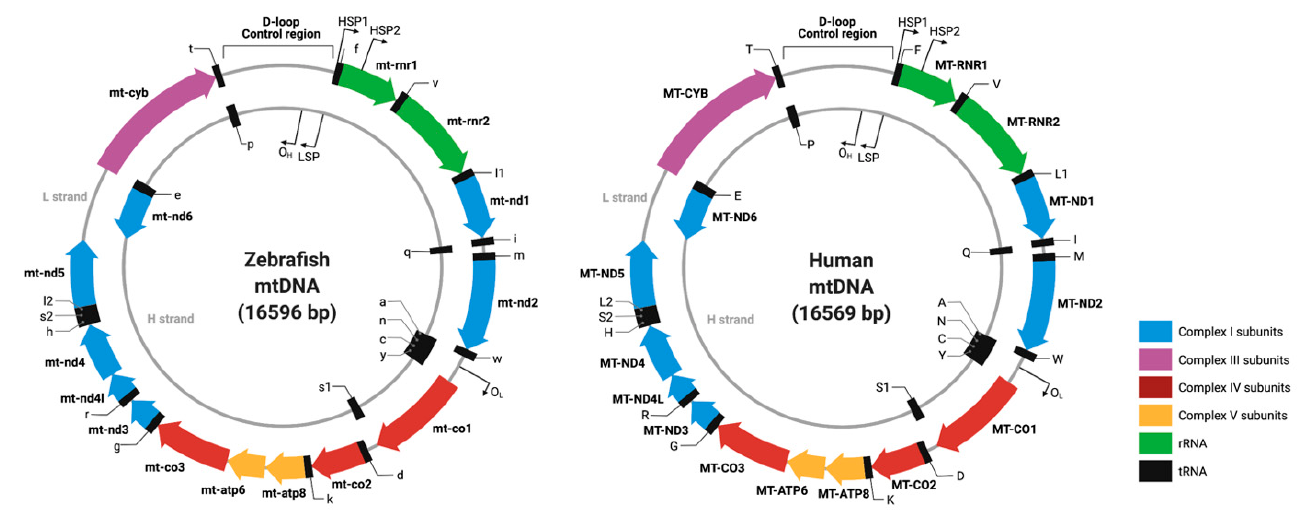
Figure 1. Circular representation of the zebrafish and human mitochondrial genomes: Both genomes share the same synteny, and the number of genes and are nearly identical in size.